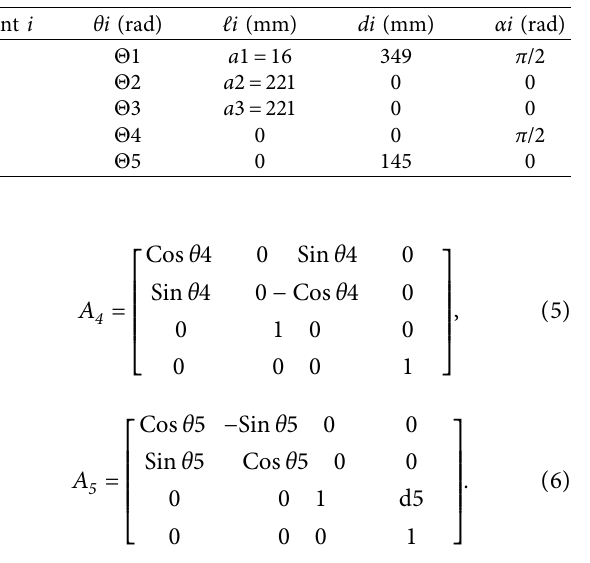
Figure 2: DH parameters assigned. Table 1: DH